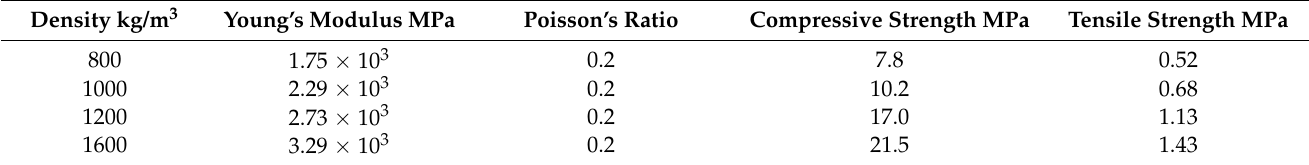
Table 5. Mechanical properties for foam concrete.